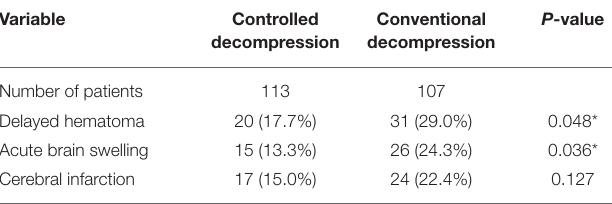
TABLE 3 | Comparison of post-operative complications between the two groups.